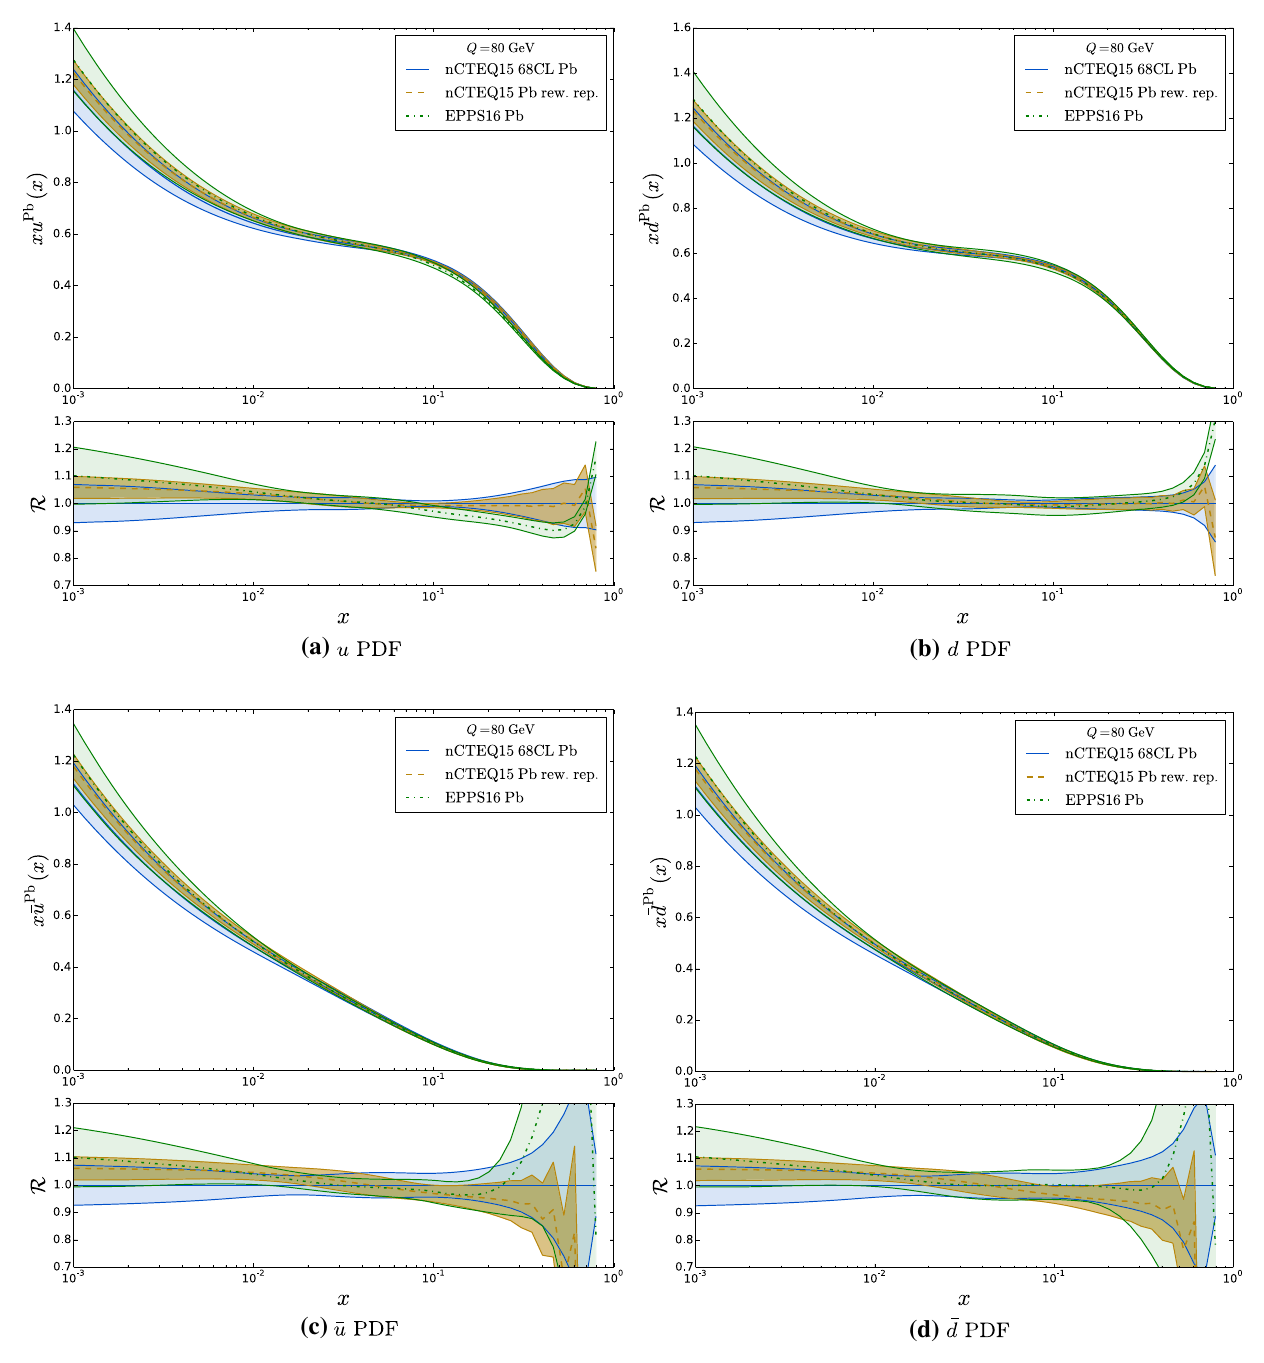
Fig. 30 Comparison of the nCTEQ15 PDFs before and after the reweighting using all pPb data sets with the EPPS16 PDFs including LHC data. The EPPS16 error bands include only the nuclear errors